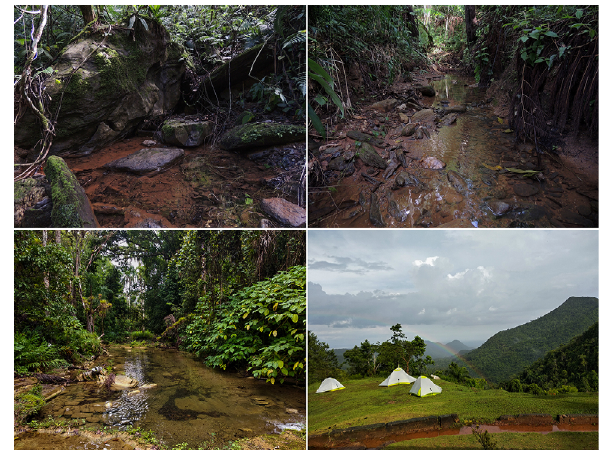
Figure 2. Localities where Epilobocera capolongoi was collected in Lomas de Banao Ecological Reserve. Upper left, tributary source of Banao river; upper right, tributary source of Higuanojo river. Lower left, Banao river, near María Antonia ranger station. Lower right, view from La Sabina ranger station, after a heavy rain.